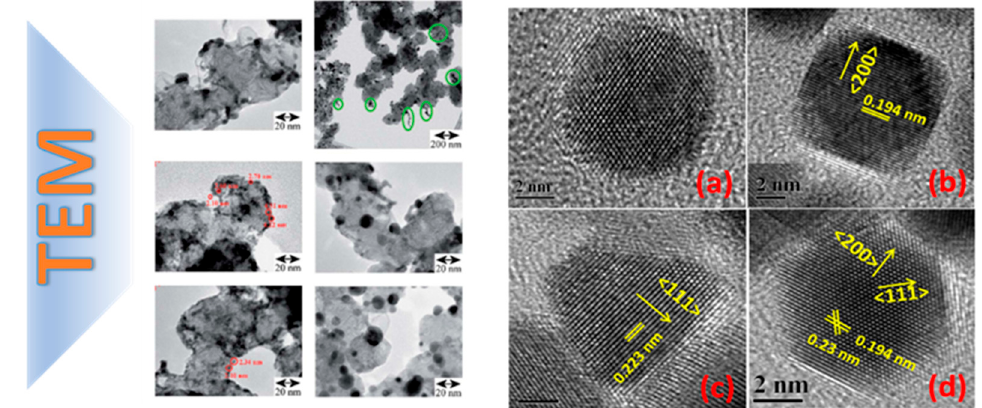
Figure 9. STEM detection of atomically dispersed Pd atoms on TiO 2 metal oxide. ( a – d ) STEM images of different Pd/TiO 2 samples. Adapted from [31] with permission.